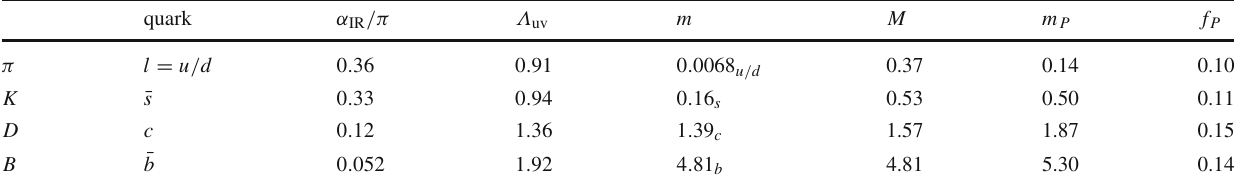
Table 2 Couplings, α IR /π , ultraviolet cutoffs, Λ uv , and current-quark masses, m f , f = u / d , s , c , b , that deliver a good description of flavoured pseudoscalar meson properties, along with the dressed-quark masses, M , and pseudoscalar meson masses, m P , and leptonic decay constants, f P , they produce; all obtained with m G = 0 . 5GeV, Λ ir =